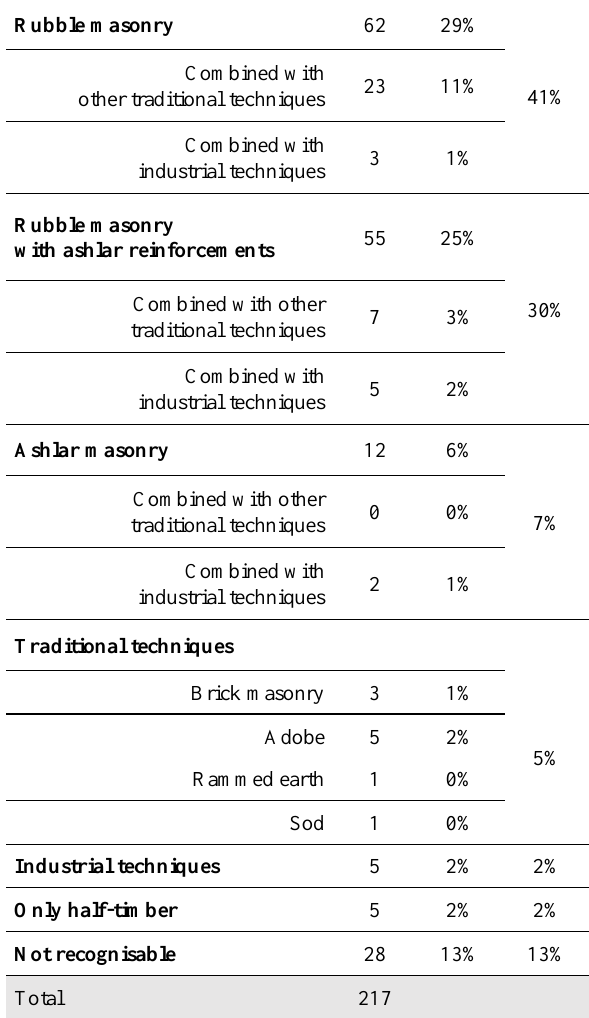
Table 7. Presence of other building